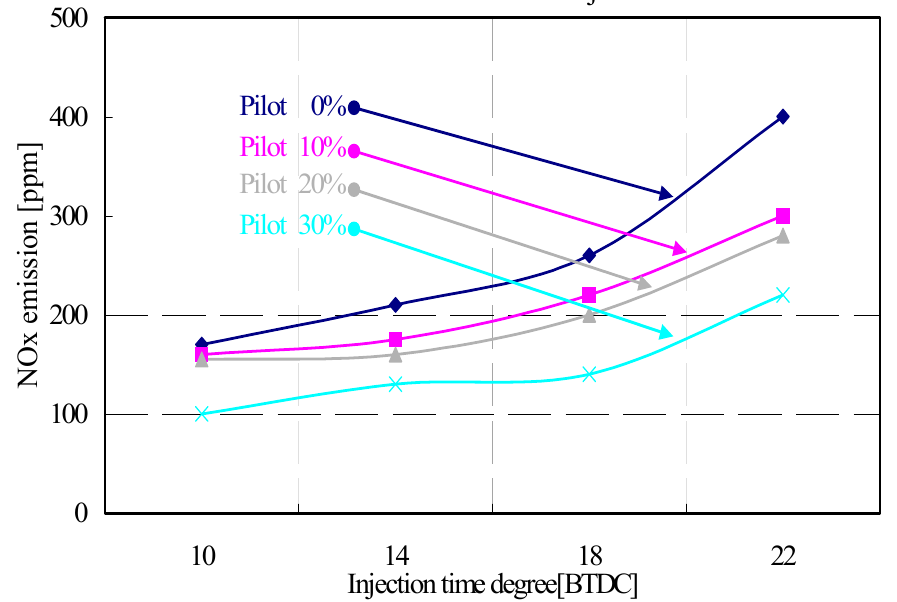
Figure 11. NO x emission characteristics of DME engines with the pilot injection duration rate as a function of injection